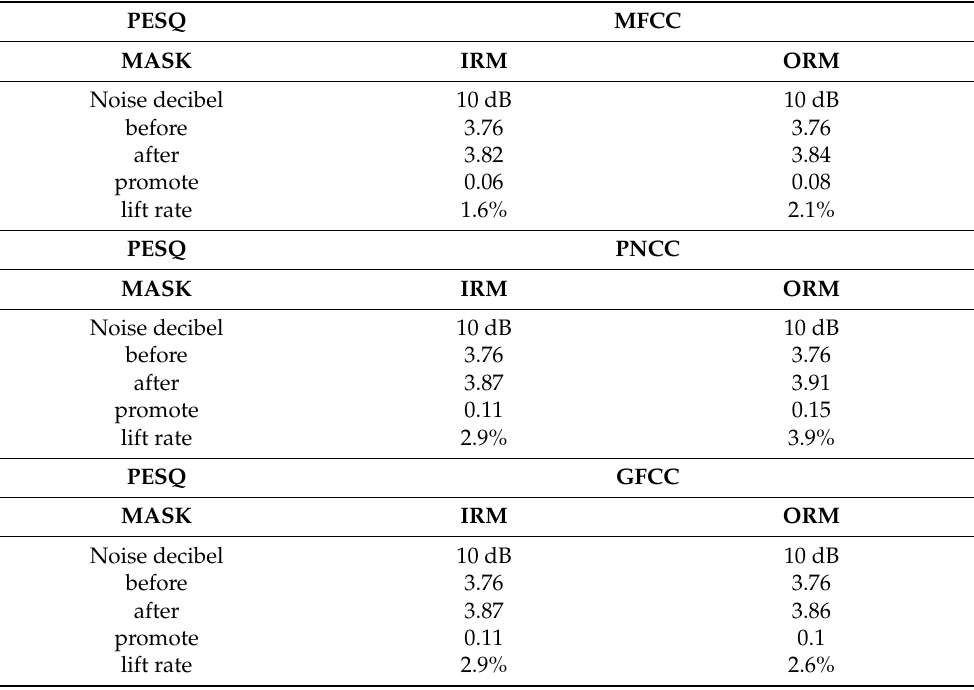
Table 5. Feature Extraction Method and Mask Comparison 1.